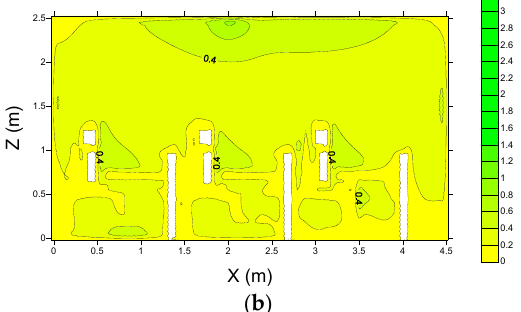
Figure 6. Air velocity field in the virtual classroom with 6 occupants in the plans ( a ) X = 1.791 m and ( b ) Y = 0.63099 m, with an inlet air temperature of 20 °C.